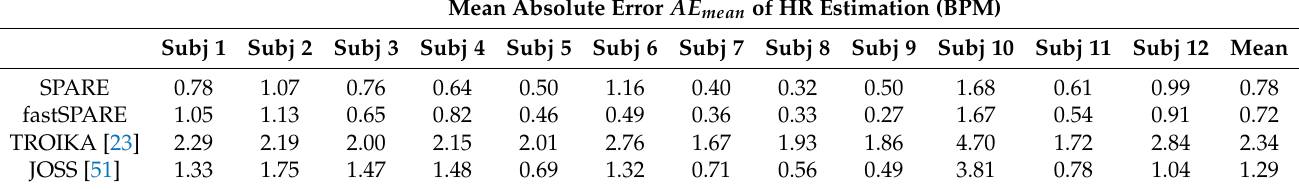
Table 3. Mean absolute error ( AE mean ) for SPARE, fastSPARE, and TROIKA by comparing heart rate error (BPM) from ECG (RR-intervals) and PPG (PP-intervals) on windows on 8 s and overlap of 2 s. Mean Absolute Error AE mean of HR Estimation